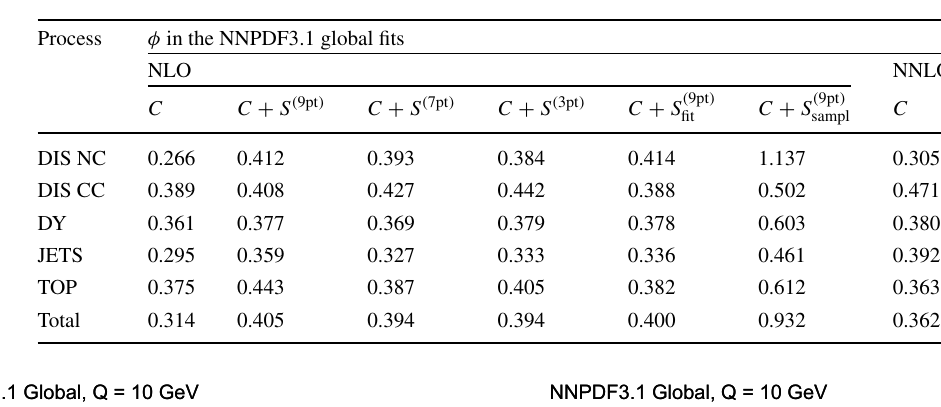
the corresponding NLO PDF sets in which no MHOU is